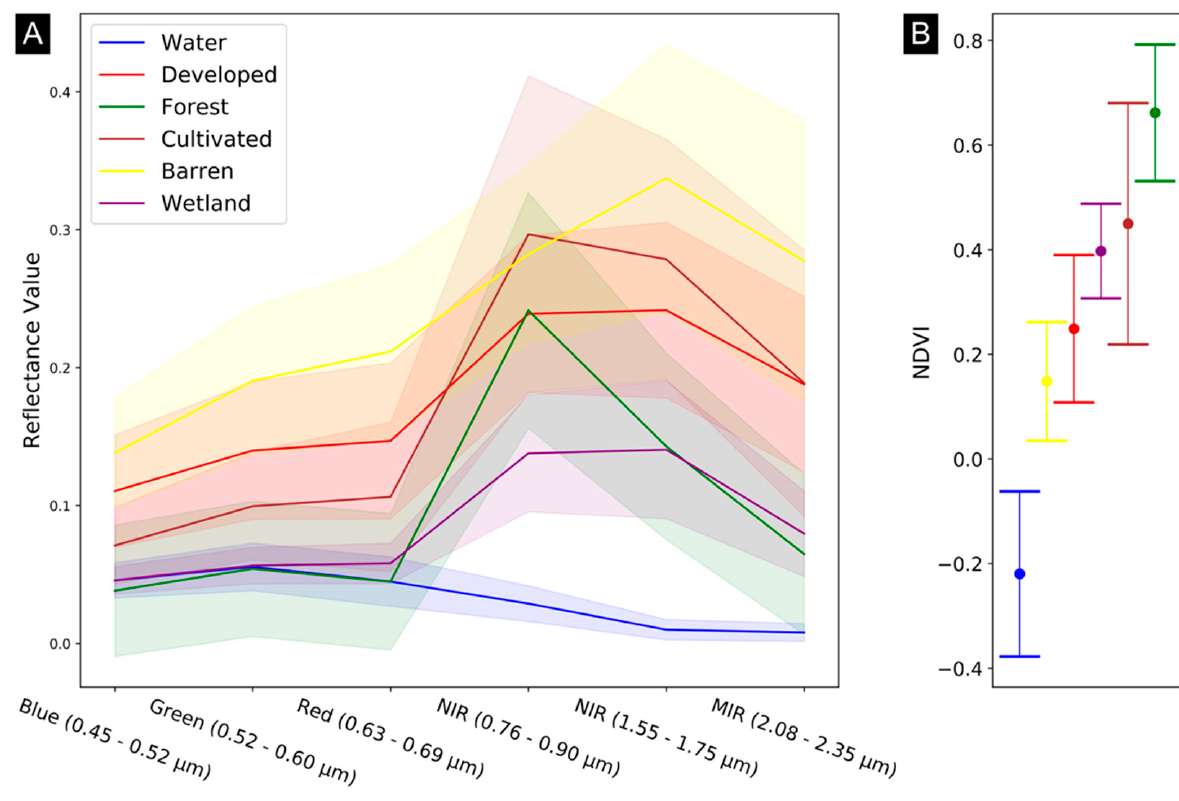
Figure 4. Spectral signatures and NDVI values for each class in the study. In panel ( A ) the heavy lines represent the mean for each class and the shaded area is the standard deviation. On panel ( B ) points represent mean NDVI and bars represent the standard deviation. Values were based on training labels and reflectance values from August 2011.